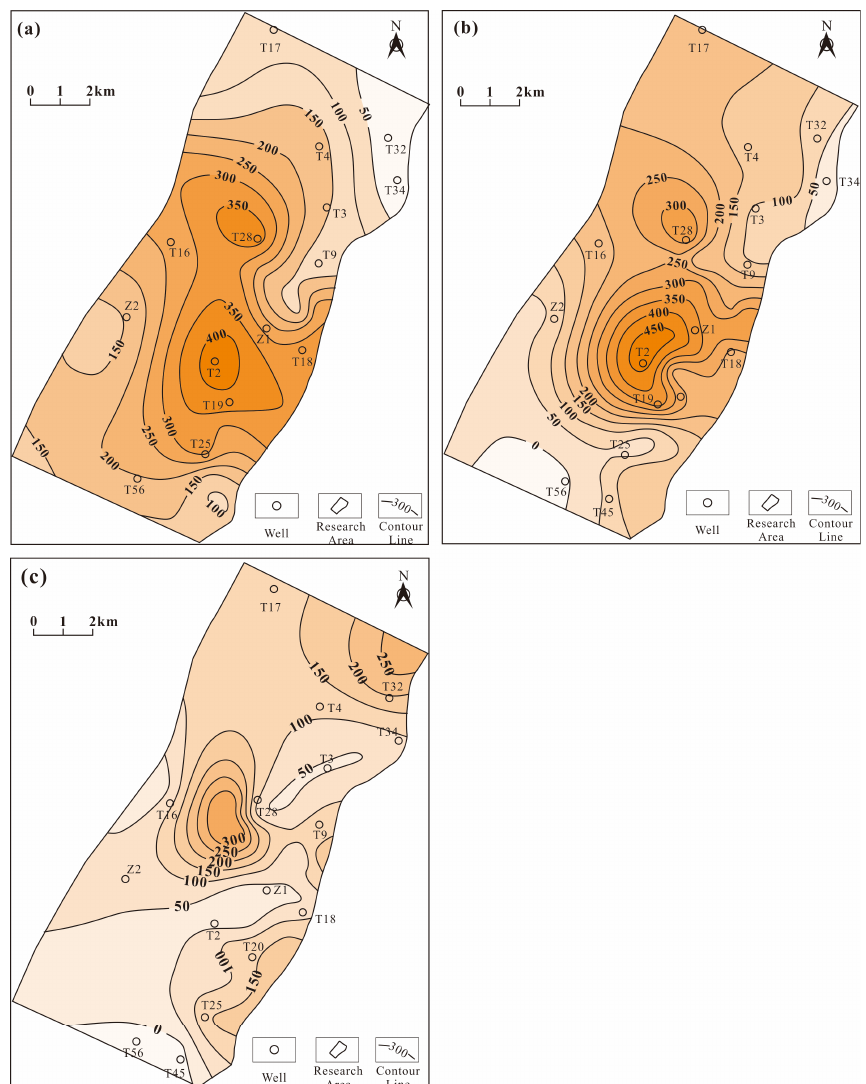
Figure 4. Thickness distribution map of the Es4 source rocks in the study area. ( a ) The Es4d source rocks; ( b ) The Es4g source rocks; ( c ) The Es4n source rocks.